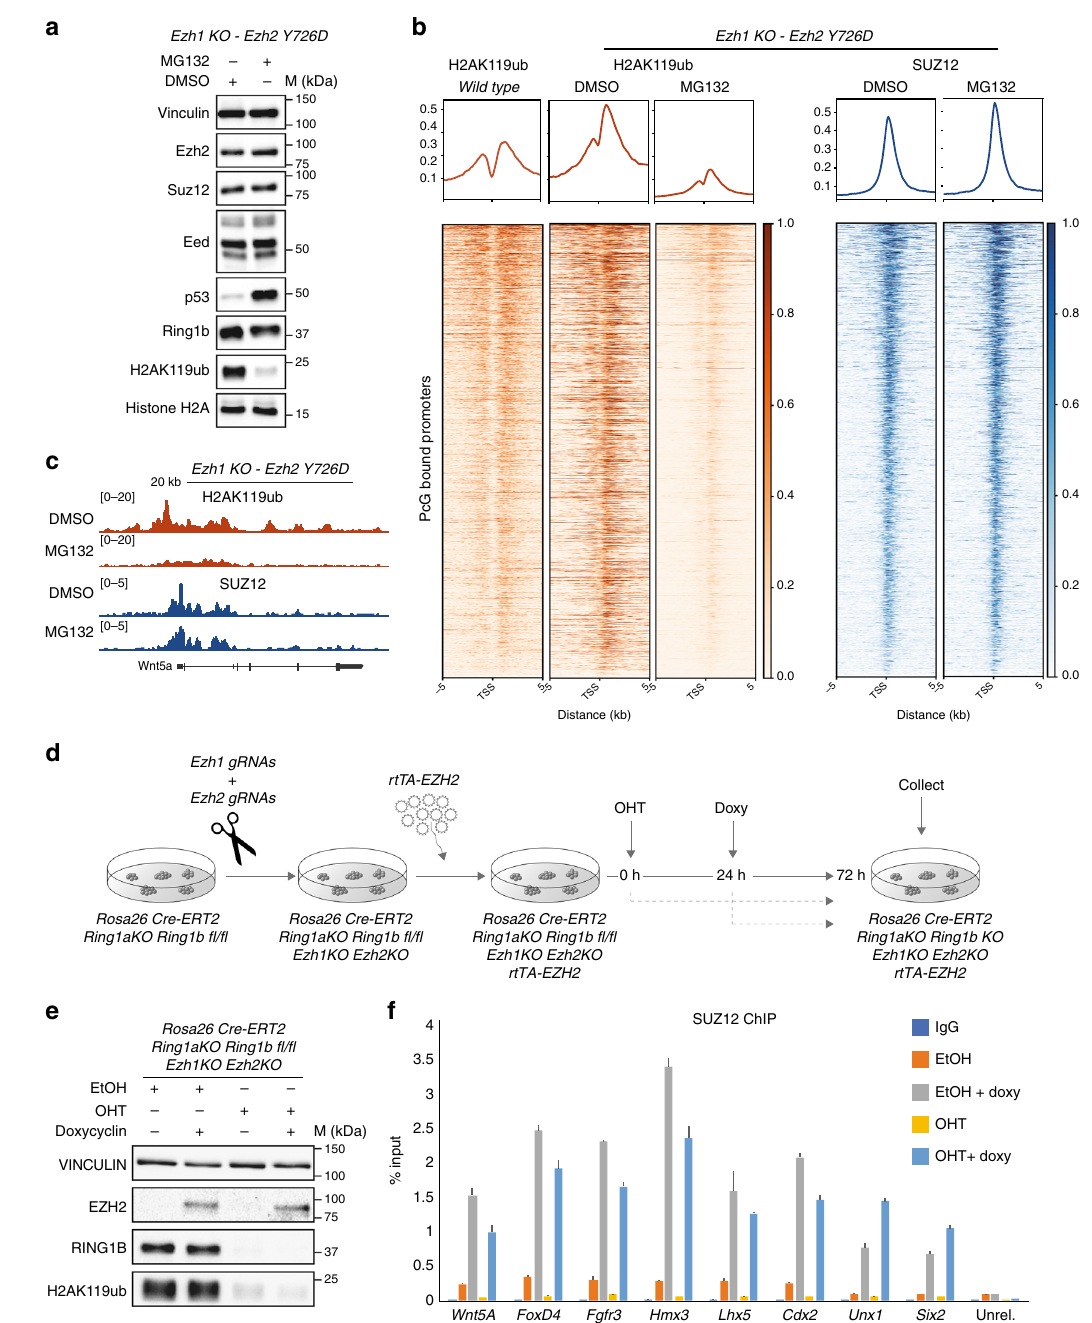
Fig. 4 PRC2 recruitment is not affected by acute loss of H2Aub1 deposition. a Western blot analysis with the indicated antibodies of total protein extracts obtained from Ezh1 KO- Ezh2 Y726D cells upon treatment with DMSO (vehicle) or 10 µ M MG132 for 6 h. TP53 served as positive control for MG132 treatment. Vinculin and histone H2A were used as loading controls. b Heatmaps representing the spike-in normalized H2AK119ub ChIP-seq intensities and the normalized SUZ12 ChIP-seq signals± 5 kb around TSS of SUZ12-bound promoters/targets in Ezh1 KO- Ezh2 Y726D cells upon treatment with DMSO or MG132. Promoters were ranked according to their intensities in WT mESCs. Enrichment plots representing the average distribution of H2AK119ub and SUZ12 ± 5 kb around TSS are shown in the upper panels. c Genomic snapshot of H2AK119ub1 and SUZ12 of the analysis performed in b at the Wnt5a locus. d Experimental strategy used for de novo recruitment performed in Rosa26:Cre-ERT2, Ring1a KO, Ring1b fl / fl , Ezh1 KO, Ezh2 KO ESC transduced with a doxycycline inducible lentiviral vector expressing EZH2. e Western blot analysis with the indicated antibodies of total protein extracts obtained from cells described in d , treated with EtOH (vehicle) or OHT (0.5 μ M) alone or in combination with doxycycline (1 μ g/ml). Vinculin was used as loading control. f qPCR of SUZ12 ChIP in the same cells used in e , upon treatment with EtOH or OHT (0.5 μ M) alone or in combination with doxycycline (1 μ g/ml). Rabbit IgG served as negative control. Enrichments are normalized to % INPUT. Data are represented as mean ±